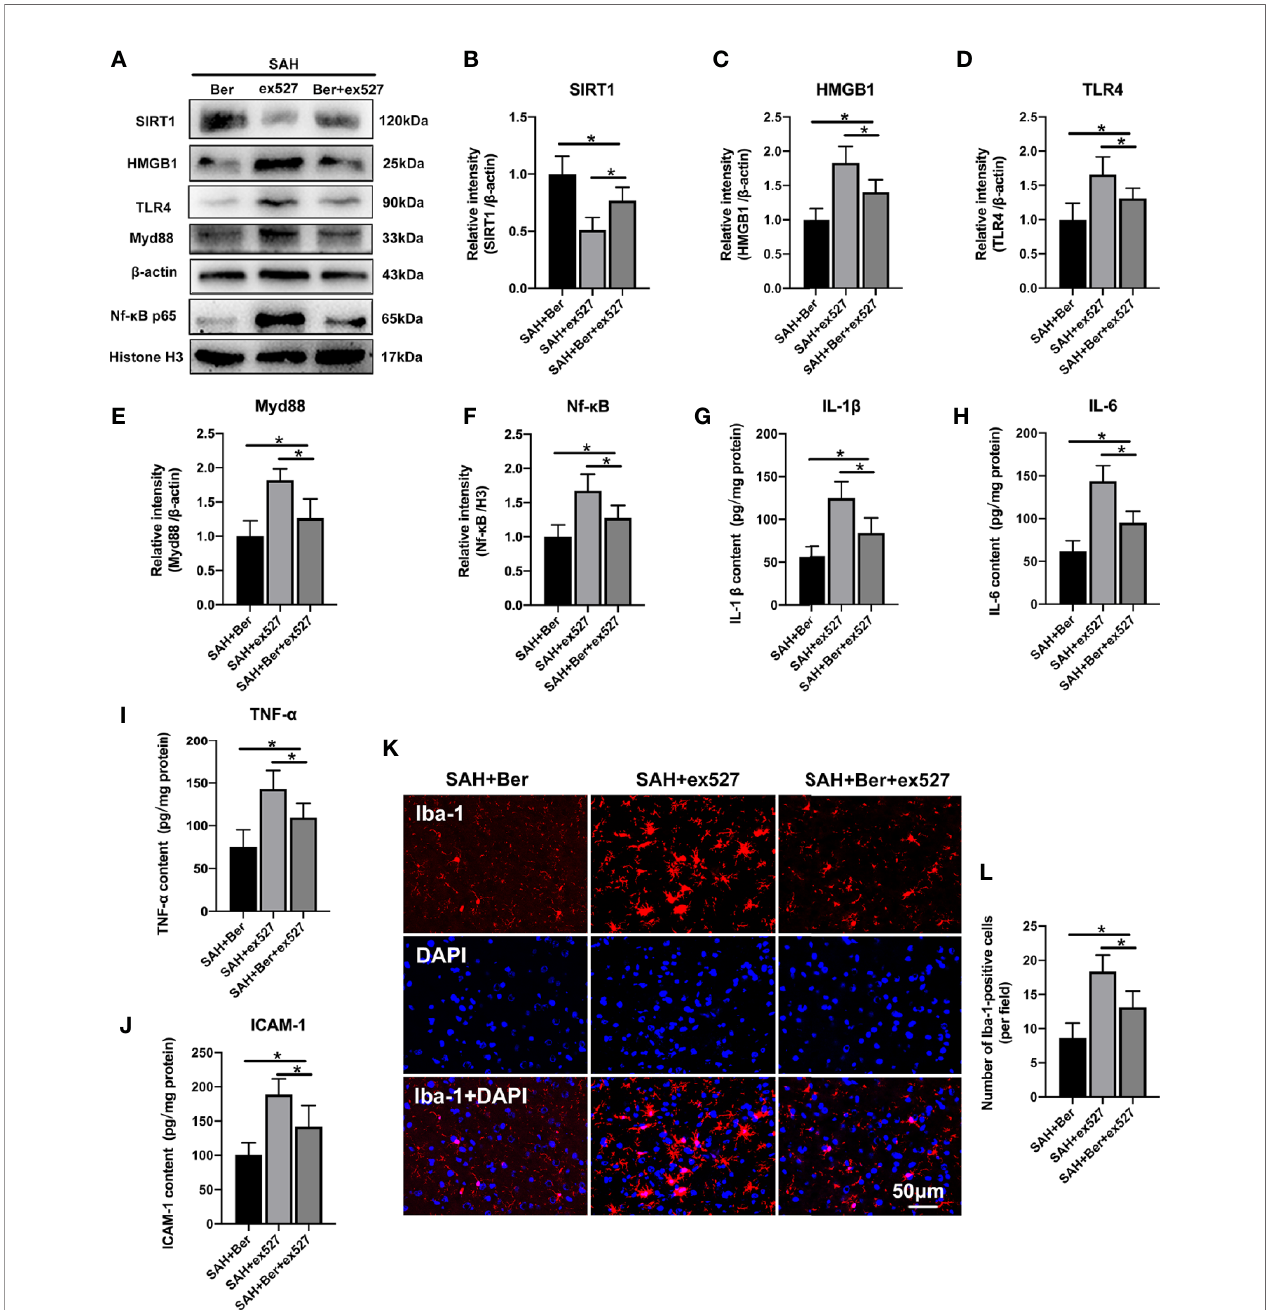
FIGURE 5 | Effects of ex527 treatment on SIRT1/HMGB1/TLR4/Myd88/Nf- k B signaling pathway after SAH. (A – F) Western blot assay (A) and quanti fi cation for the expression of SIRT1 (B) , HMGB1 (C), TLR4 (D) , Myd88 (E) , and Nf- k B p65 (F) in the indicated groups. n = 6 per group. (G – J) Quanti fi cation of IL-1 b (G) , IL-6 (H) , TNF- a (I) and ICAM-1 (J) protein expressions in all groups. n = 6 per group. (K) Representative photomicrographs of immuno fl uorescence staining for Iba-1. (L) Quantitative analysis of the Iba-1 immuno fl uorescence staining. n = 6 per group. Bars represent the mean ± SD. * P <